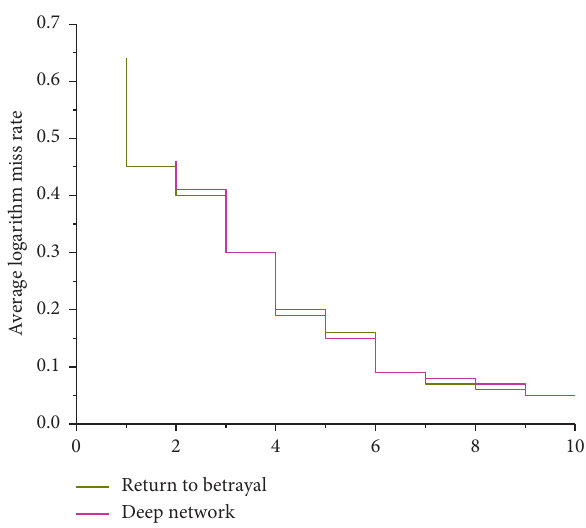
Figure 10: Average number of false positives per